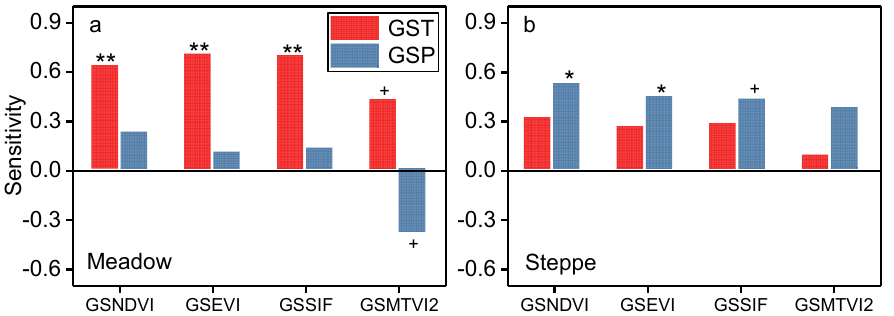
Figure 4. Sensitivity of the vegetation indices to GST and GSP during 2000–2019 for the meadow ( a ) and steppe ( b ) on the TP during 2000–2019. Labels +, * and ** in ( c , d ) indicate the significance levels of 0.1, 0.05 and 0.01, respectively.